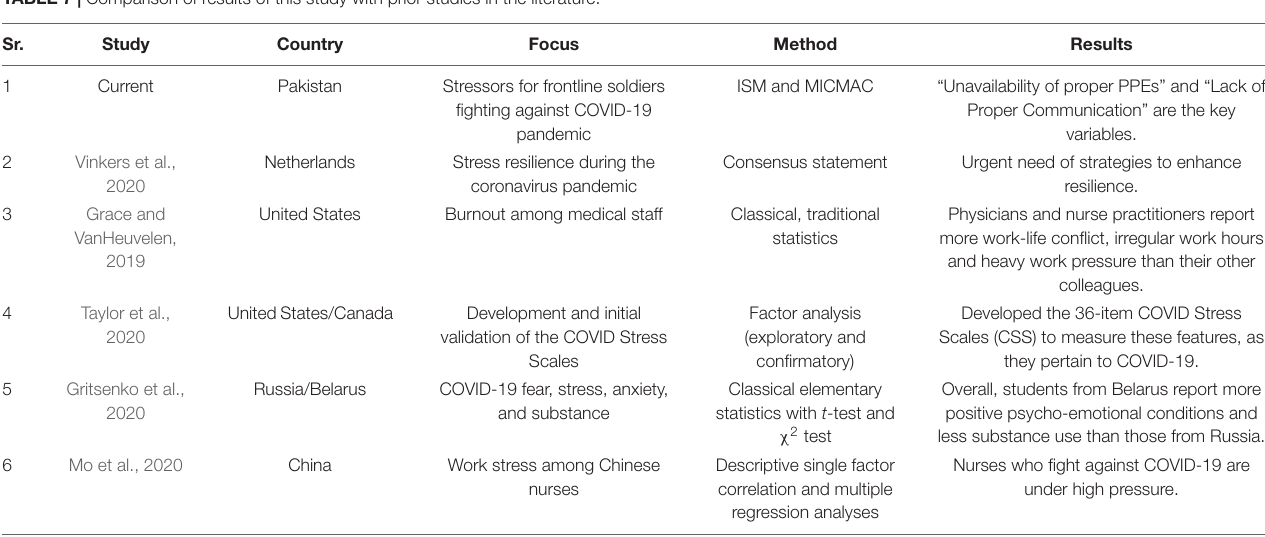
TABLE 7 | Comparison of results of this study with prior studies in the literature.